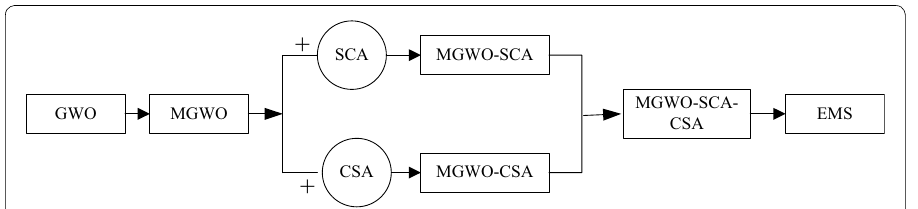
Fig. 1 Block diagram of proposed